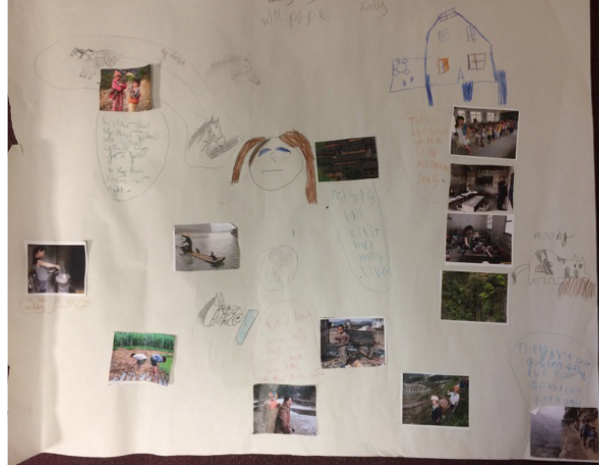
Figure 2. Example of a storyboard created by the children about the day in the life